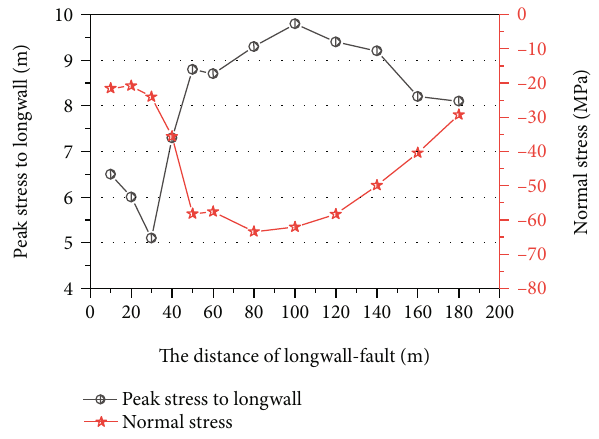
Figure 7: Variation in stress peak and position during the advancement of the longwall